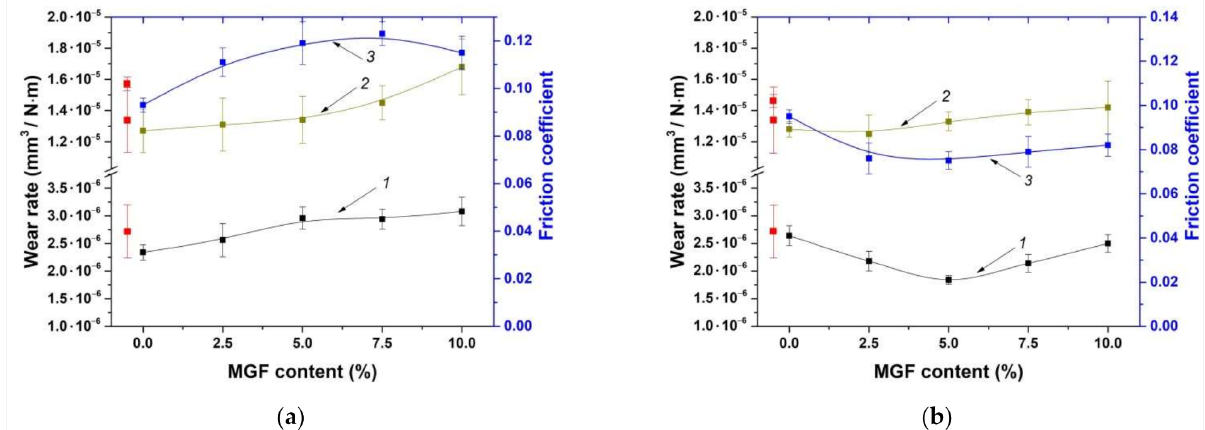
Figure 4. Wear rates according to the ‘pin-on-disk’ (curve 1, 5 N · 0.3 m/s) and ‘block-on-ring’ (curve 2, 60 N · 0.3 m/s) schemes as well as the average friction coefficients (curve 3) versus filler weight fraction: HC-PM ( a ), HC-TSE ( b ).